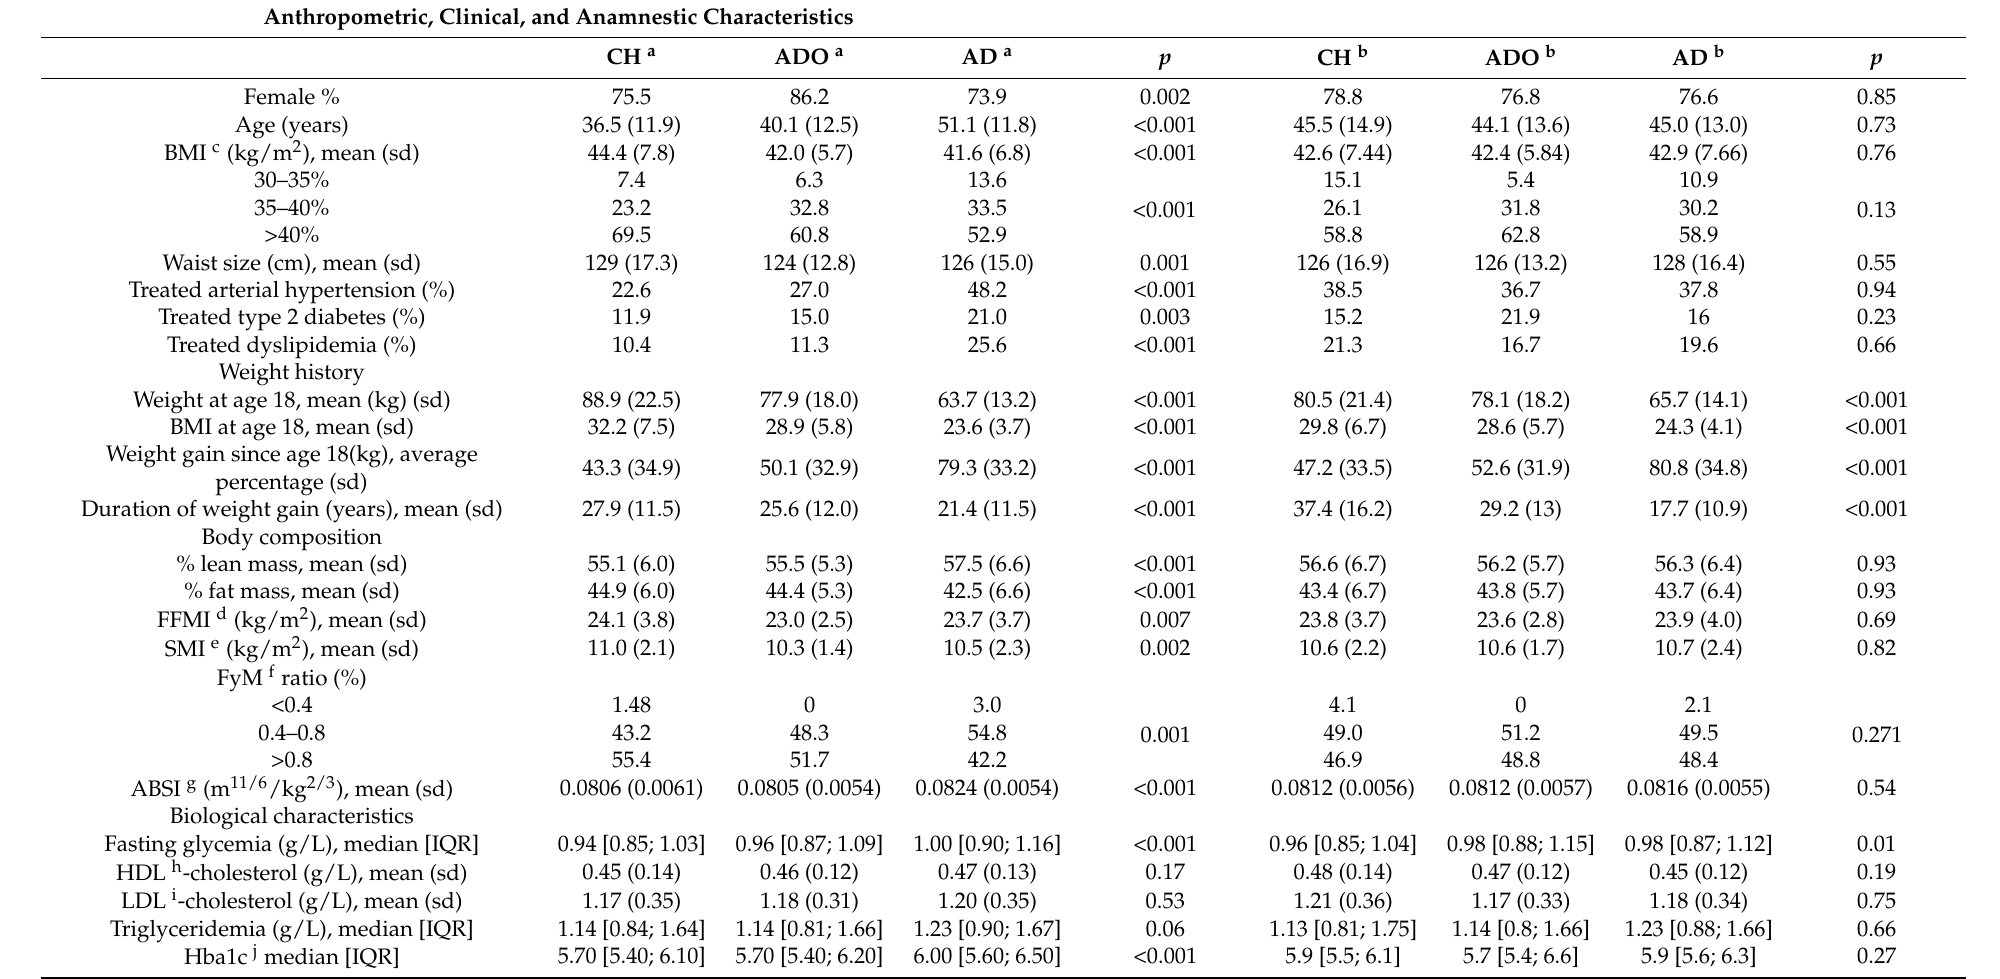
Table 1. Description of the characteristics of the study population ( n = 950) and its three groups: CH ( n = 298), ADO ( n = 189), and AD ( n = 463). Anthropometric, Clinical, and Anamnestic